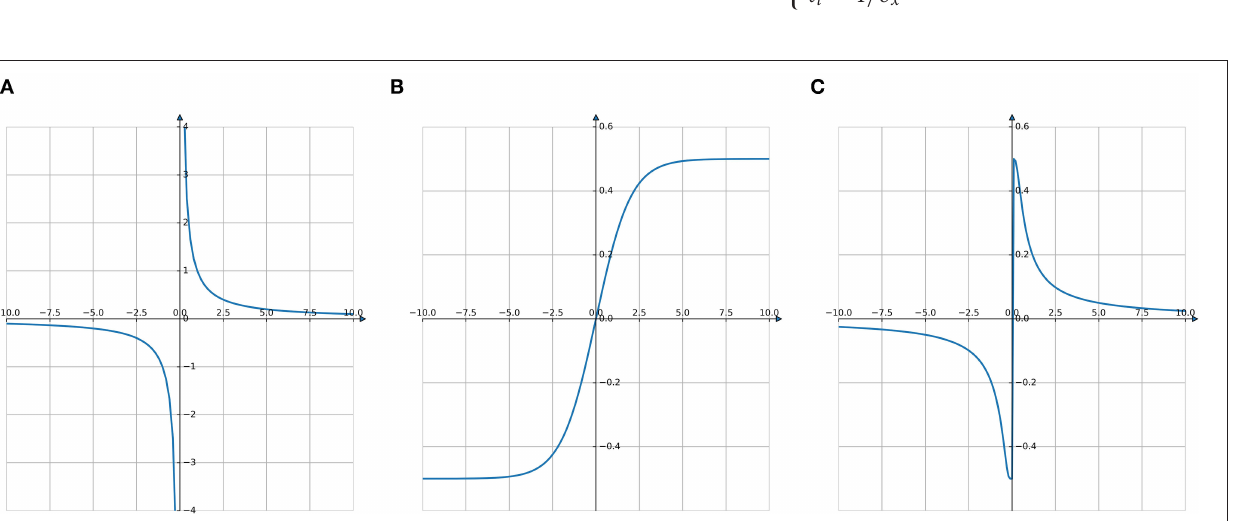
FIGURE 5 | The relationships between safety status and the spatial scaling parameters. In (A) , the horizontal axis is the scalar value of the ESPI, and the vertical axis shows the safety status of the human-exoskeleton system. The larger the value of the vertical axis, the safer the system. In (B) , the horizontal axis is the safety status of the system, and the vertical axis shows the spatial scaling parameter τ s for the gait trajectory generator based on DMPs. In (C) , the horizontal axis is the scalar value of the ESPI, and the vertical axis shows the spatial scaling parameter τ s for the gait trajectory generator based on DMPs.